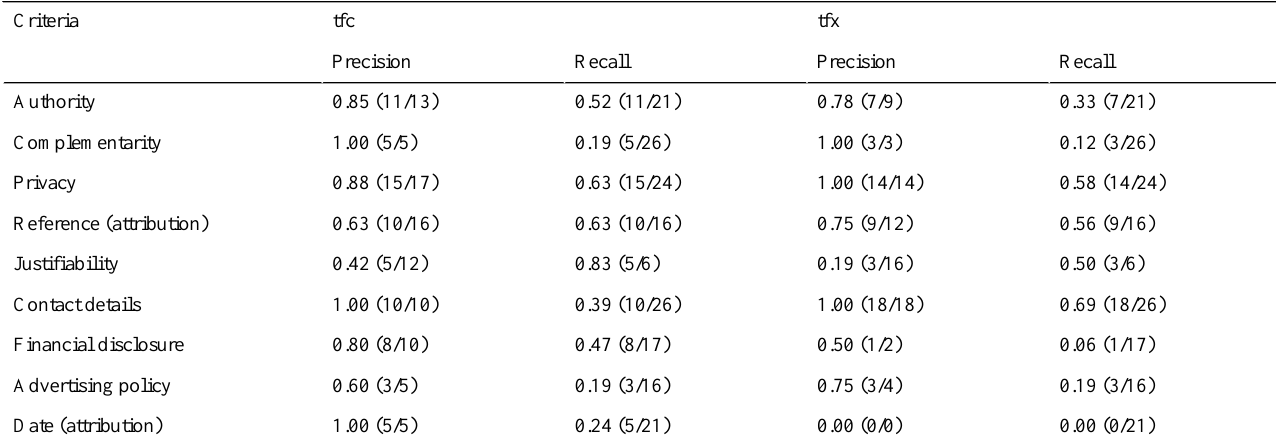
Table 2. Precision and recall of automated HONcode